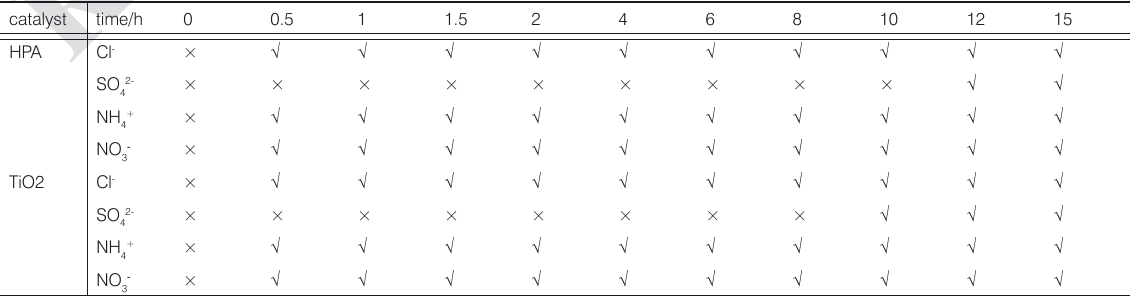
Table 3. Anion products of photocatalytic degradation of KGN. catalyst